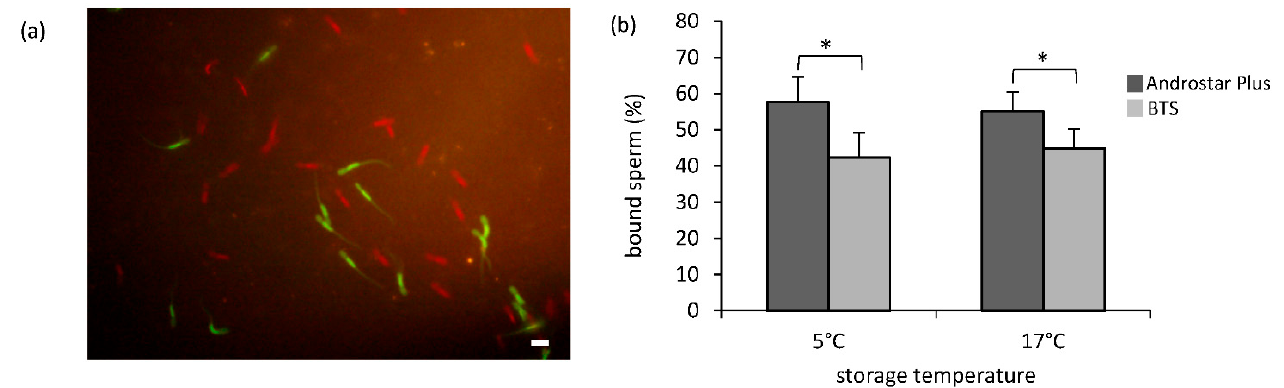
Figure 3. Effect of storage temperature and semen extender on sperm binding in the competitive oviduct explant assay. A competitive oviduct explant assay was applied to directly compare the ratio of oviduct-bound spermatozoa for semen samples which had been stored for 24 h in either Beltsville Thawing Solution (BTS) or Androstar ® Plus at 5 °C or 17 °C. ( a ) Exemplary image from video recording of MitoTracker ® Green- or MitoTracker ® Red-tagged sperm bound to the oviduct explant surface (scale bar = 20 µm). ( b ) The semen extender had a significant impact on the percentage of sperm that were bound to oviduct explants. An asterisk (*) indicates significant differences between the percentage of bound sperm per extender at a given storage temperature ( n = 7 boars; p < 0.05).